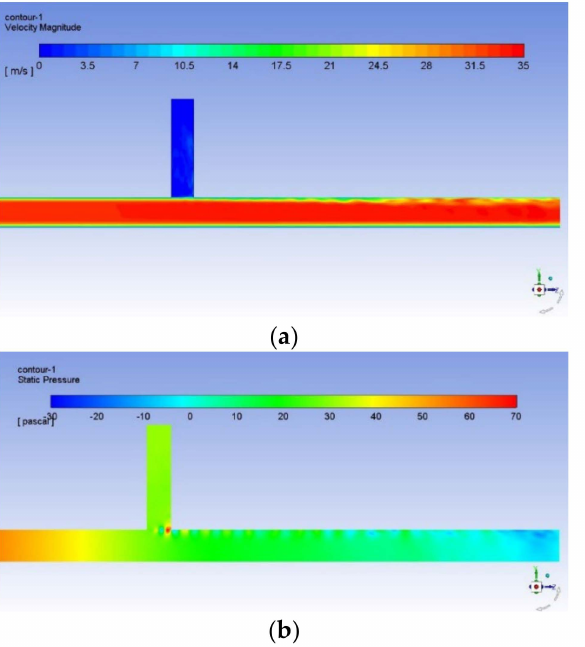
Figure 6. Simulation results with 261 mm cavity: ( a ) the computed flow rate; ( b ) the computed static pressure.